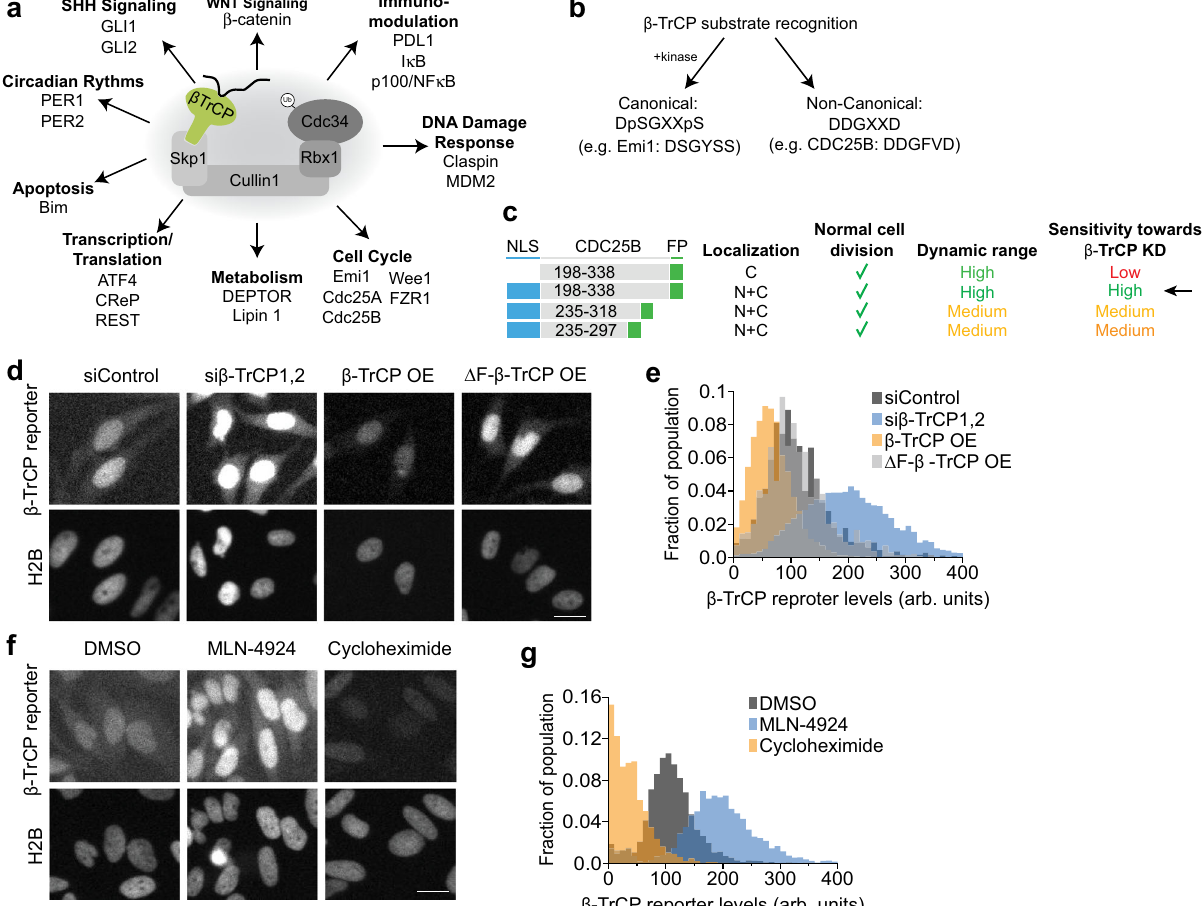
Fig. 1 | Construction of a generalizable β -TrCP reporter. a Schematic showing several known substrates of β -TrCP and the pathways it regulates. b β -TrCP recognizes two types of degron sequences. Canonical substrates like Emi1 contain the degronDpSGXXpSwhereby the Sor serineresidue mustbephosphorylatedto bind to β -TrCP. Non-canonical substrates like CDC25B contain a degron consisting of phospho-mimetic amino acids (D or E) in place of serine residues. For example, CDC25BcontainsaDDGFVDdegronsequence. c Variousconstructswithfragments ofhumanCDC25BfusedtomVenus.Eachconstructwasevaluatedusingthecriteria listed.TheconstructwiththebestattributeswasNLS-CDC25B(aa198 – 338)-mVenus (hereafter β -TrCP reporter). NLS nuclear localization signal, C cytoplasmic, N nuclear, √ = Pass, x = Fail. d HeLa cells expressing the β -TrCP reporter and H2B- mTurquoise to visualize the nucleus. Cells were treated as indicated with either